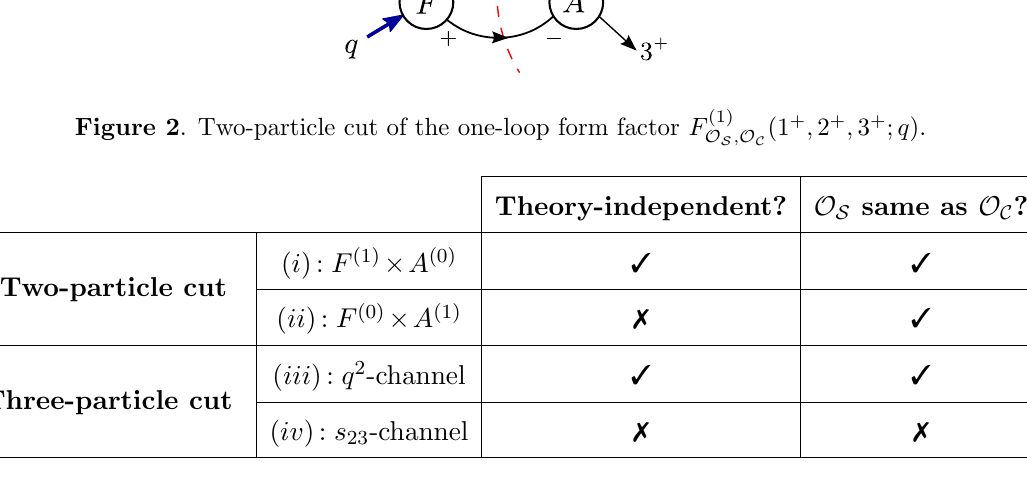
Table 1 . Summary of the theory- and operator-dependence of the unitarity cuts of the two-loop form